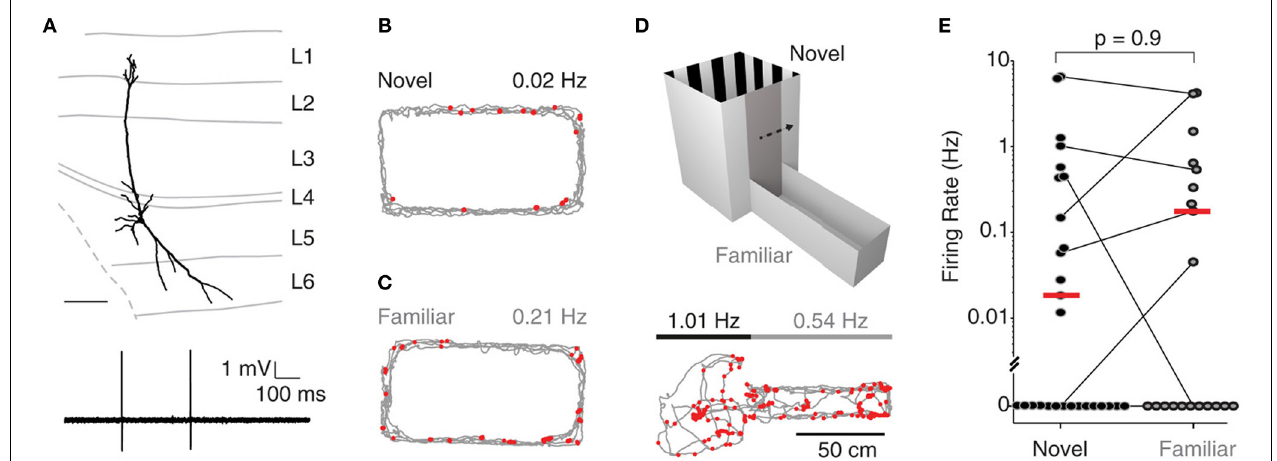
FIGURE 1 | Deep layer neurons in MEC fire at low rates irrespective of spatial experience. (A) Top, reconstruction of the dendritic morphology of the L5 neuron of MEC recorded during exploration of a two-compartment maze (recording shown in D ). Scale bar = 200 µ m. Bottom, representative spike trace recorded during freely-moving behavior. (B) Firing locations of spikes (red) and trajectory of the rat (gray) during running in a novel environment (O-maze). Average firing rate is indicated. (C) Same as in (B) , but for a familiar environment. (D) Top: The two-compartment maze used for